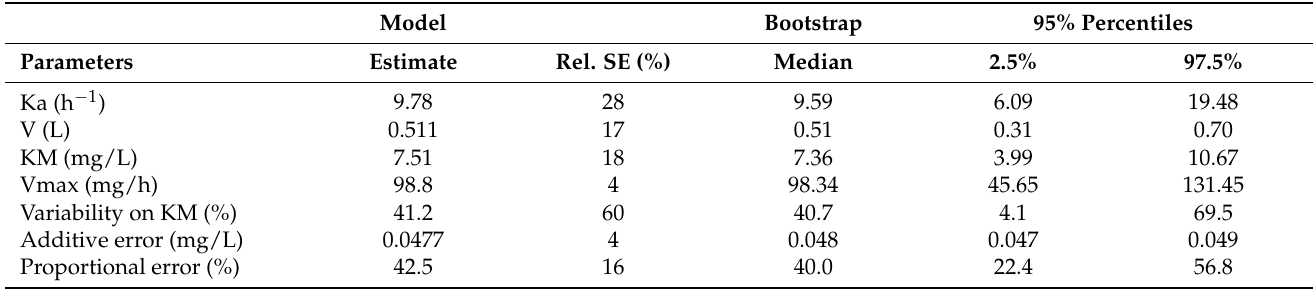
Table 1. Final estimates and